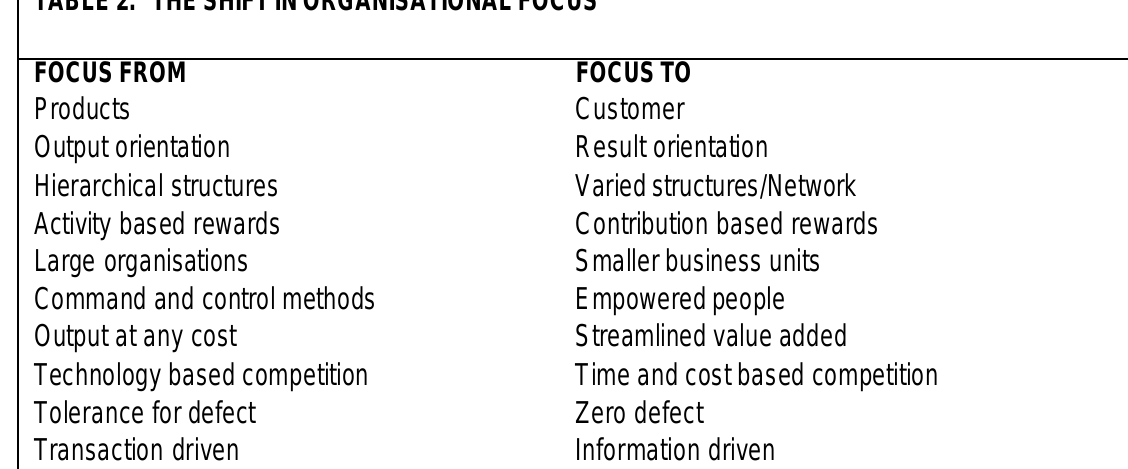
TABLE 2: THE SHIFT IN ORGANISATIONAL FOCUS FOCUS FROM FOCUS